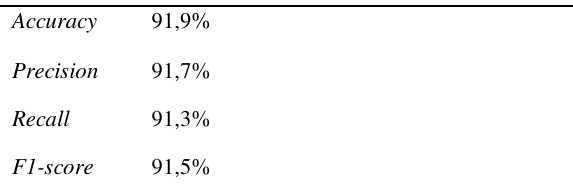
Table 4. Validation measures of the final